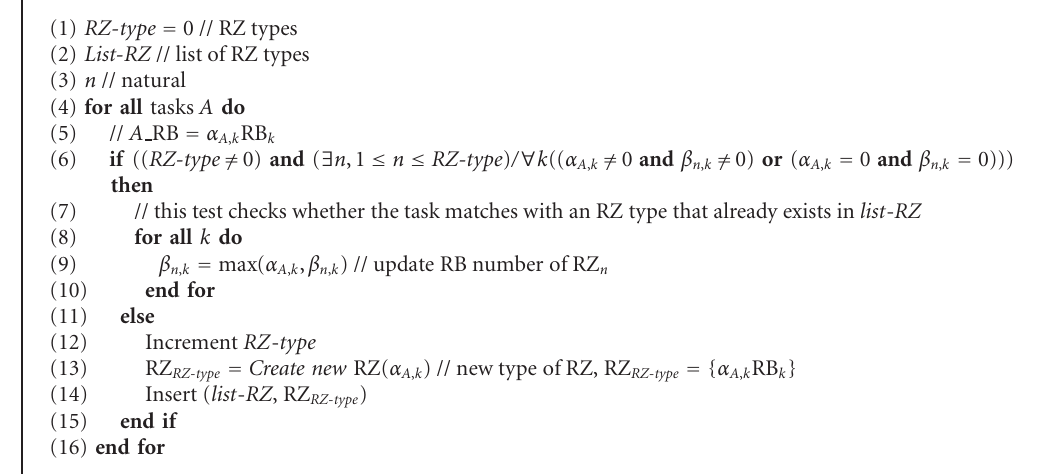
Algorithm 1: RZ types search or hardware task classes search.